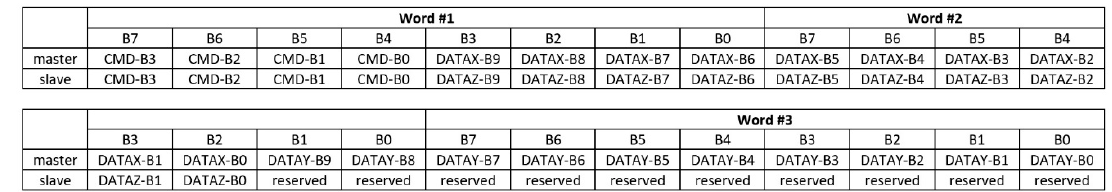
Figure 4. Packet structure for serial peripheral interface (SPI) bus communication.